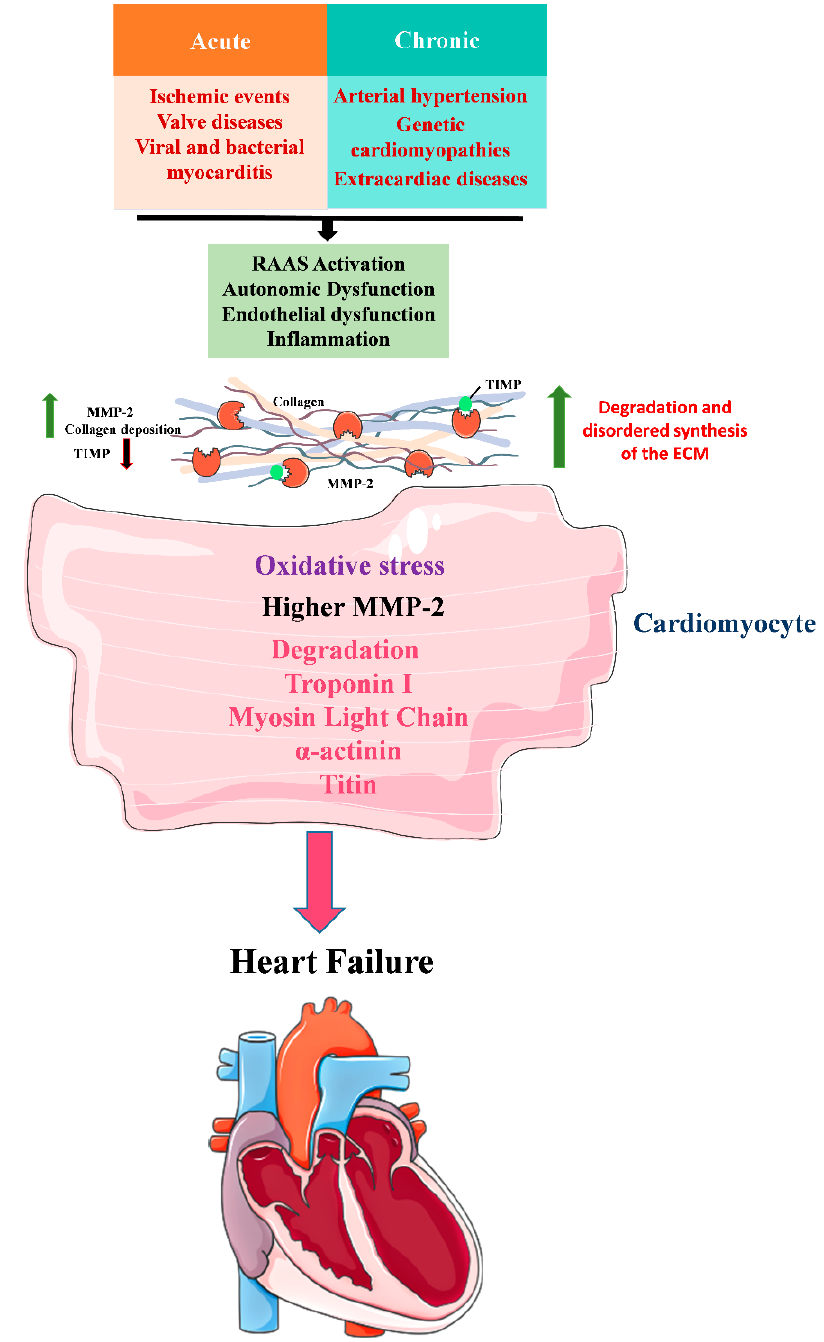
Figure 1. Cardiac remodeling in HF. HF occurs after an acute or chronic harmful event. The conditions that trigger this disease are hypertension, valvular diseases, genetic cardiomyopathies, myocarditis, extracardiac diseases and ischemia, generating autonomic dysfunction and activation of the renin- angiotensin-aldosterone system (RAAS), endothelial dysfunction and inflammation. In addition, the degradation and disordered synthesis of the extracellular matrix (ECM) occurs due to increased activity of MMP-2 and decreased activity of endogenous tissue inhibitors (TIMP), leading to collagen deposition and oxidative stress, causing degradation of components of the contractile apparatus, troponin I, light chain myosin, alpha-actinin and titin, promoting structural and functional changes; image elements from